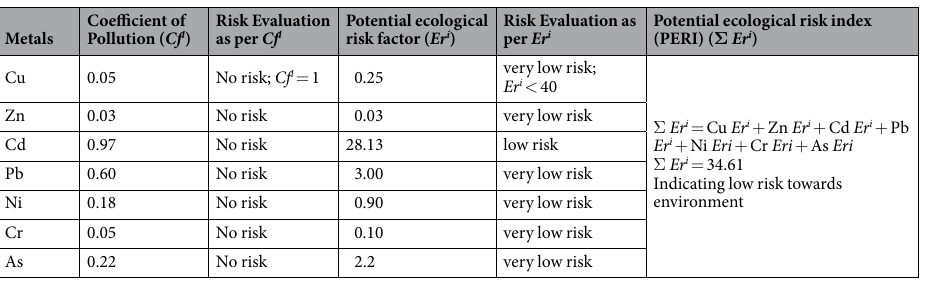
Table 8. Potential ecological risk assessment of trace elements in vermicomposted fly ash to